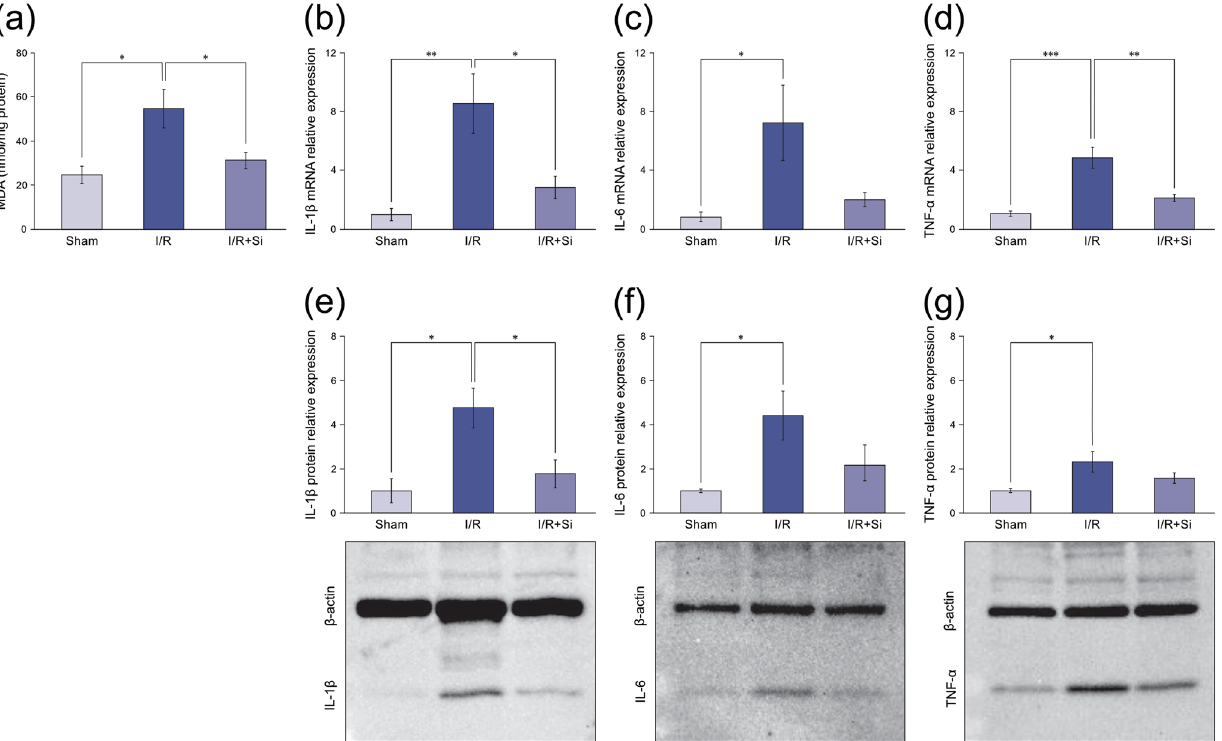
Figure 4. Oxidative stress and inflammatory cytokine measurement after ischemia–reperfusion injury. ( a ) Malondialdehyde (MDA) levels in the flap tissue of the I/R + Si group are significantly lower compared to the I/R group. ( b )–( d ) Relative mRNA levels of IL-1β and TNF-α in the flap tissue of the I/R + Si group are significantly lower compared to the I/R group. ( e )–( g ) Relative protein levels of IL-1β in the flap tissue of the I/R + Si group are significantly lower compared to the I/R group. Each representative image of Western blotting is presented. Uncropped original images are presented in the Supplementary Fig. 1. All biological replicates are presented in the Supplementary Fig. 2. Full-length blots were absent because the membranes were cut around the predicted molecular weight prior to hybridization with antibodies. (* p < 0.05, ** p < 0.01, *** p < 0.001; Tukey’s HSD multiple comparisons test, bars represent standard errors of